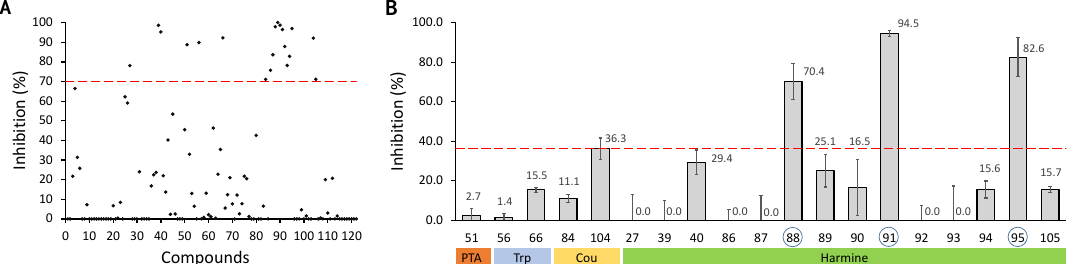
Figure 1. ( A ) Evaluation of 122 compounds for their ability to inhibit SerB2’s phosphatase activity at 100 µM in presence of 0.2 mM O -phospho-L-serine. The data depicted are averaged from two independent experiments. ( B ) Evaluation of the 19 primary hits for their ability to inhibit SerB2’s phosphatase activity at 10 µM in presence of 0.2 mM O -phospho-L-serine. The data depicted are averaged from three independent experiments ± S.E. PTA: phenyl thiazolamine. Trp: tryptophane. Cou: coumarin.